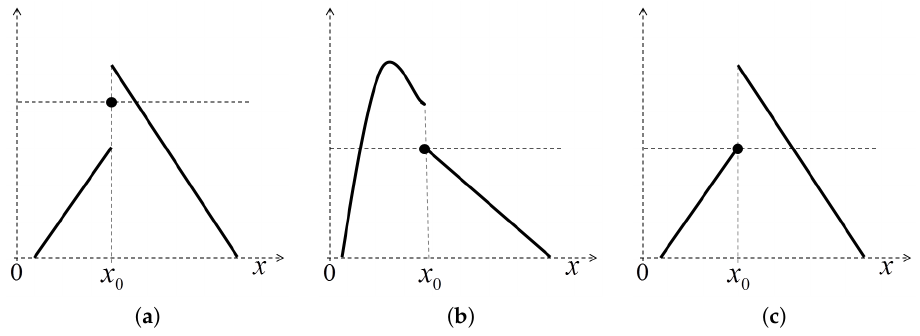
Figure 3. Non-upper semicontinuous functions: ( a ) Discontinuous from the right and from the left; ( b ) Discontinuous from the left; ( c ) Discontinuous from the